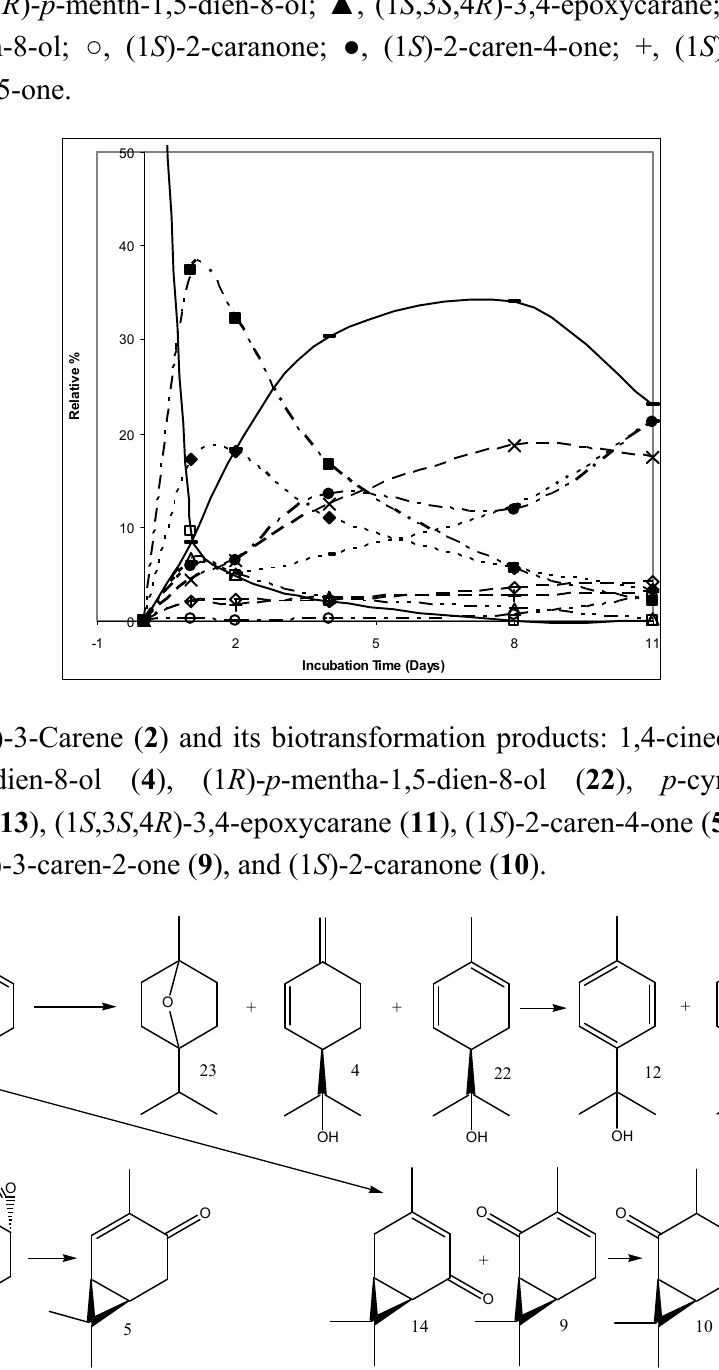
Figure 2. The relative abundance (in %) of (1 S )-3-carene and its biotransformation products in time-course; Legend: □ , (1 S )-3-carene; ◊ , 1,4-cineole; ■ , (1 R )- p -menth-1(7),2- dien-8-ol; ∆ , (1 R )- p -menth-1,5-dien-8-ol; ▲ , (1 S ,3 S ,4 R )-3,4-epoxycarane; –, m -cymen-8- ol; ×, p -cymen-8-ol; ○ , (1 S )-2-caranone; ● , (1 S )-2-caren-4-one; +, (1 S